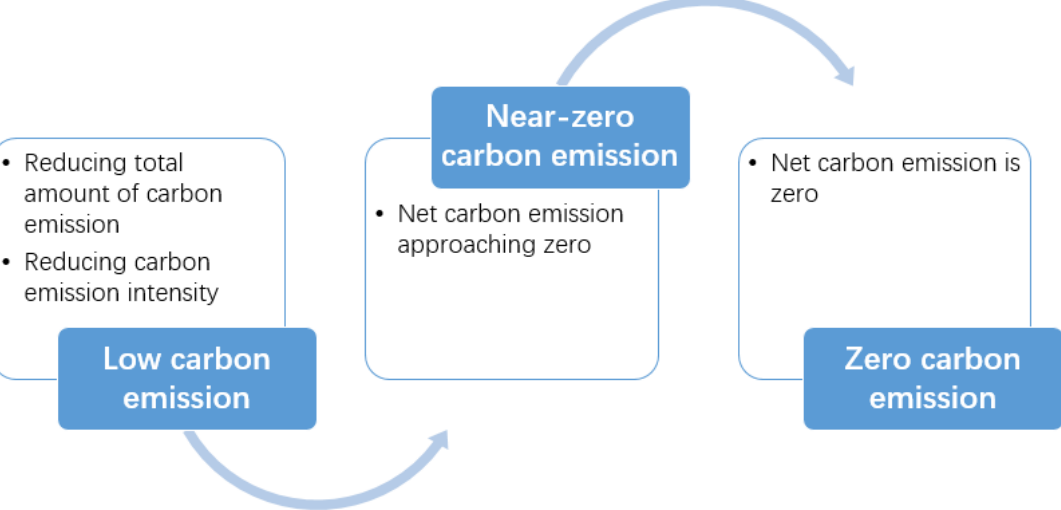
Figure 1. The relationship among near-zero carbon emissions, low carbon emissions, and zero carbon emissions.